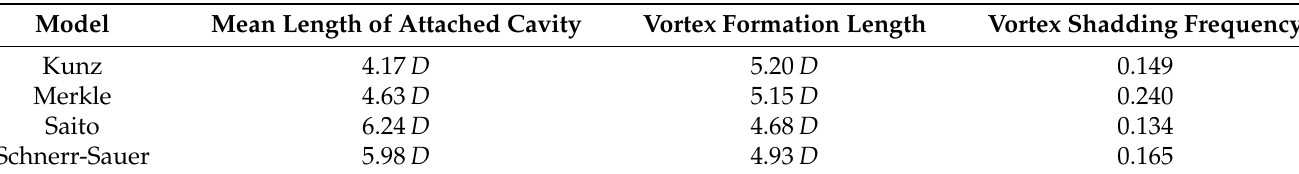
Table 8. Length of attached cavity, vortex formation length and non-dimensional vortex shadding frequency. Results obtained considering standard